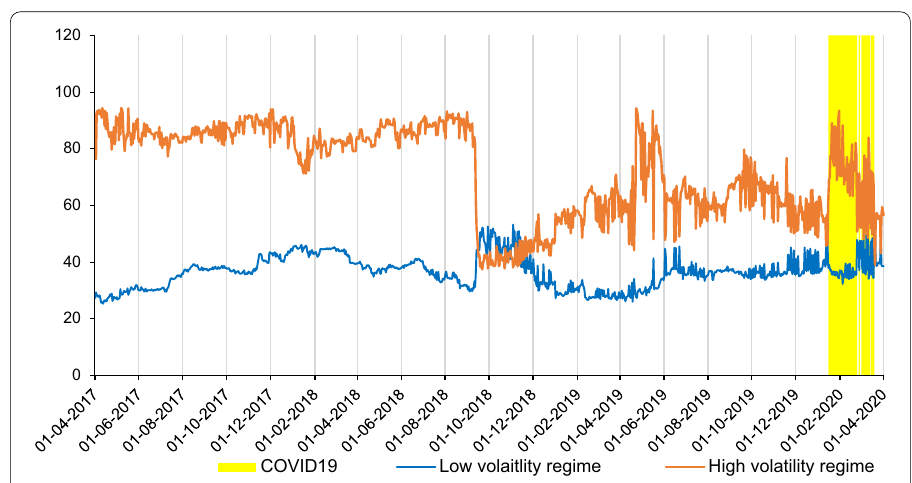
Fig. 6 Total return spillovers. Note : The rolling window total spillover indices are based on 250 days rolling window, lag 1 (based on SIC) and a forecast horizon of 12 =